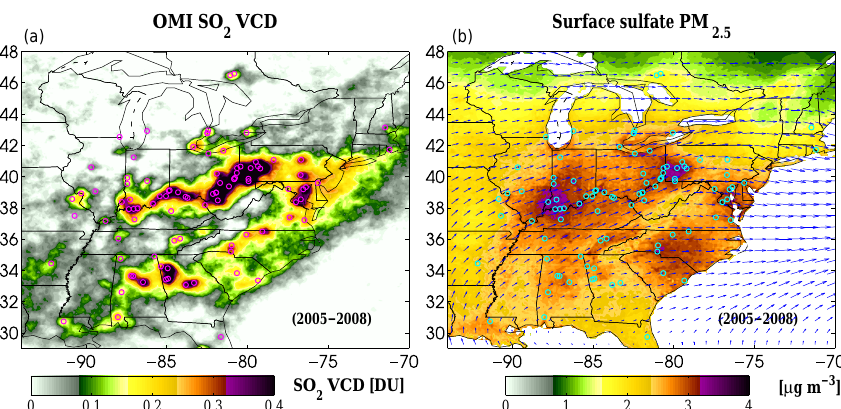
Figure 7. Spatial distribution of (a) satellite-derived SO 2 vertical column density (VCD) and (b) sulfate PM 2 . 5 mass concentration over the eastern US and southern Ontario, Canada. The power plant locations overlaid on both panels are shown as circles. ECMWF model-derived ground-level winds overlaid on the sulfate PM 2 . 5 mass concentration map are shown with